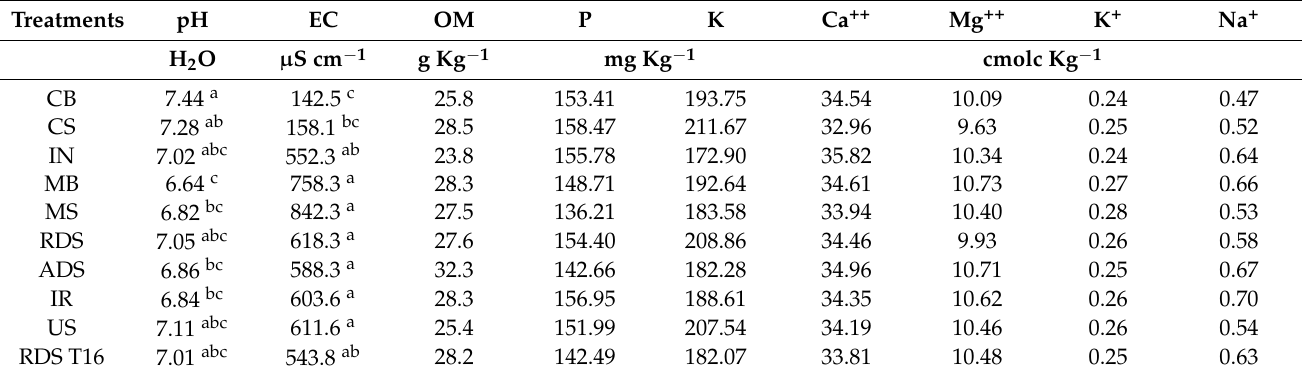
Table 3. Final soil properties, mean of three replicates. For each parameter, values followed by different letters in the same column, are significantly different based on the Tukey test ( p < 0.05). The absence of letters on the column indicates non-significant differences.